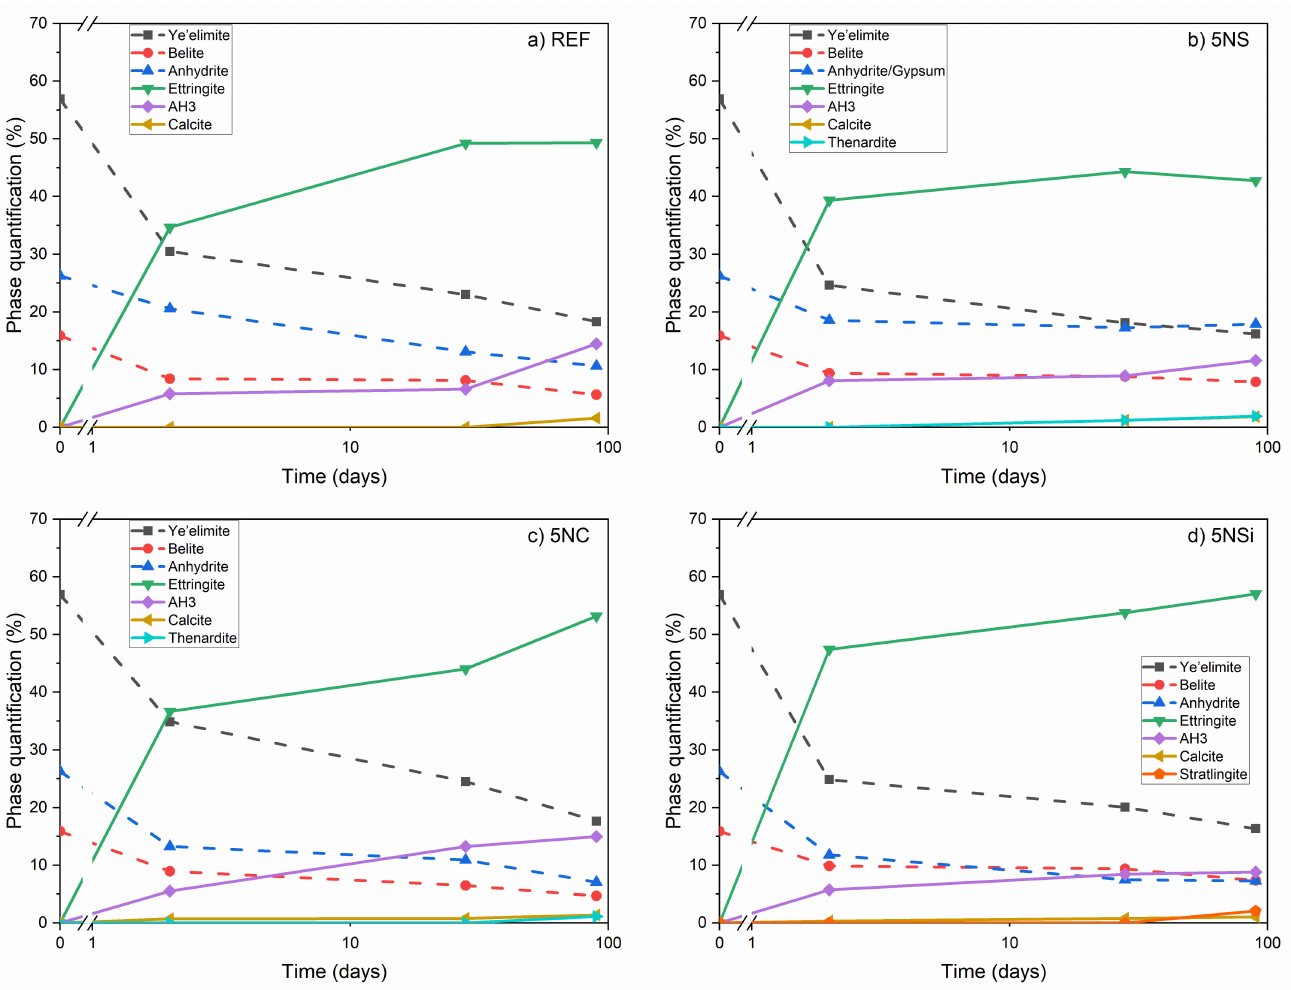
Figure 9. Phase content found by deconvoluting FTIR spectra for: ( a ) REF; ( b ) 5NS; ( c ) 5NC; and ( d )